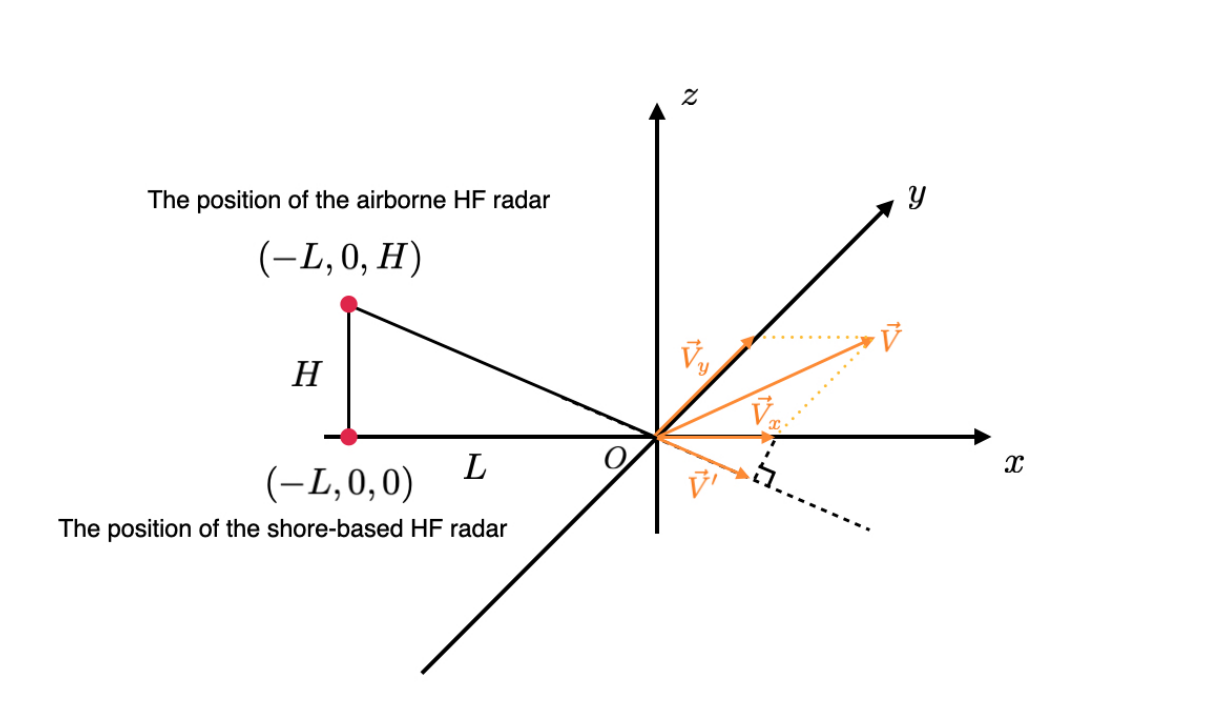
Figure 10. The difference between θ i (cid:54) = 90 ◦ and θ i = 90 ◦ for current inversion. A current with velocity vector (cid:126) V exists at the origin O . The airborne and shore-based HF radars are located at ( − L ,0, H ) and ( − L ,0,0 ) ,